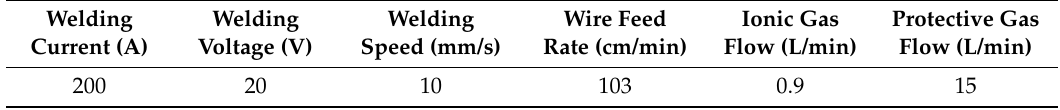
Table 5. Welding parameters of Plasma Arc Welding (PAW) for longitudinal weld.